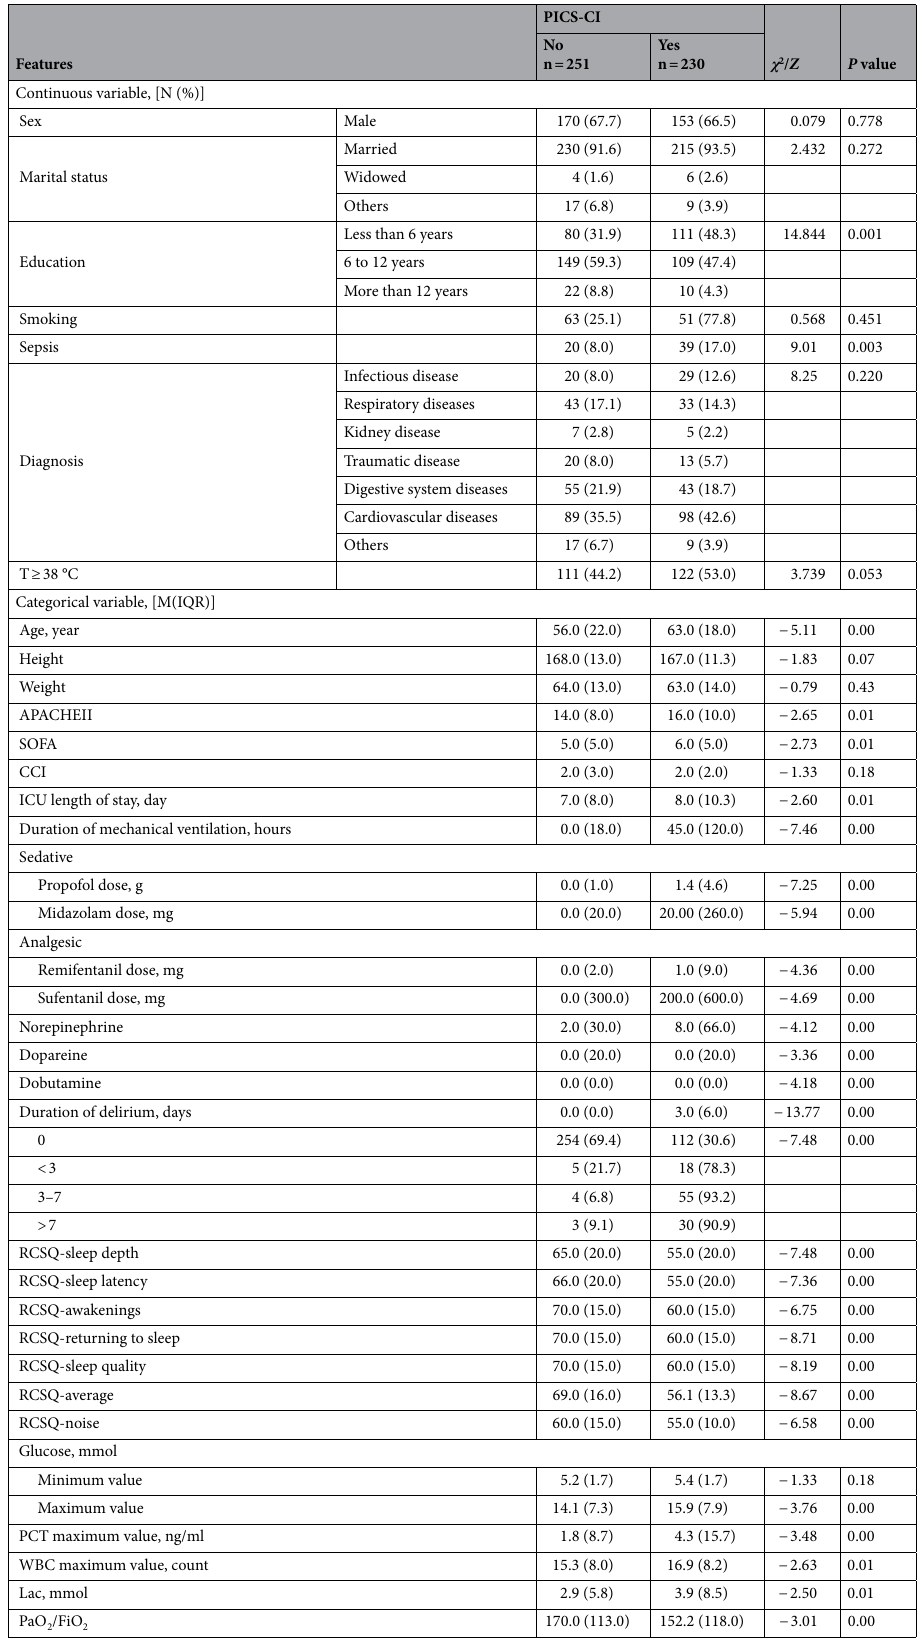
Table 1. Characteristics of the study